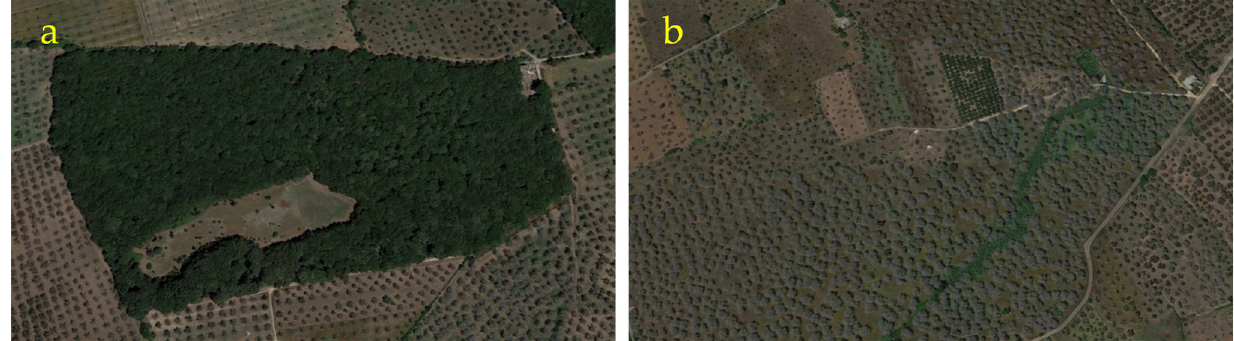
Figure 9. Examples of ( a ) forest canopy and ( b ) olive grove canopy.